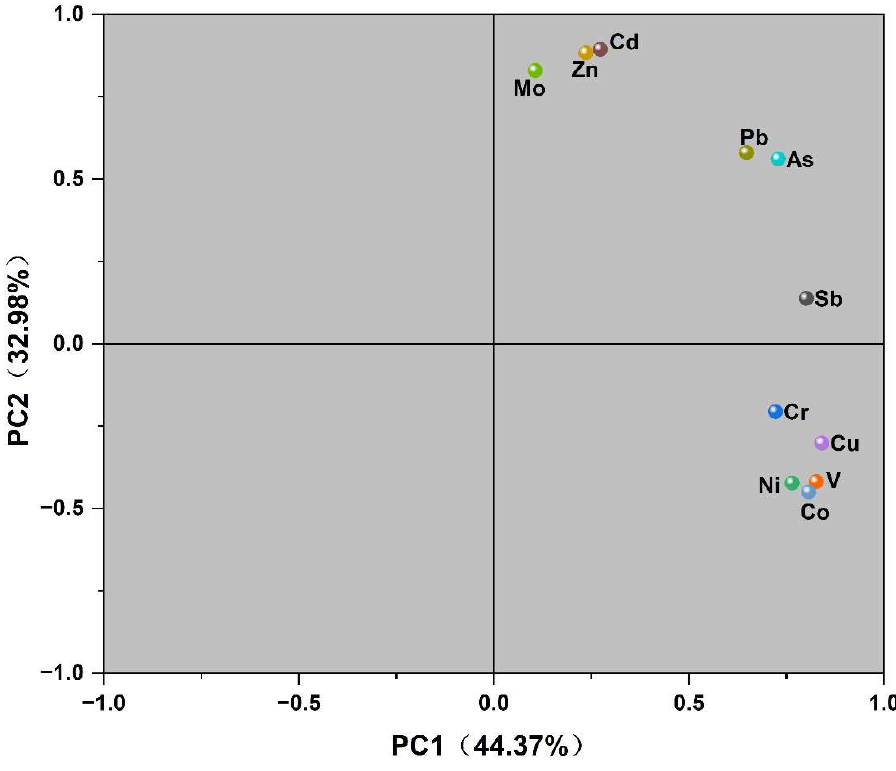
Figure 8. Principal component analysis loading plot of heavy metals. Table 4. Analysis of the main components of heavy metals in